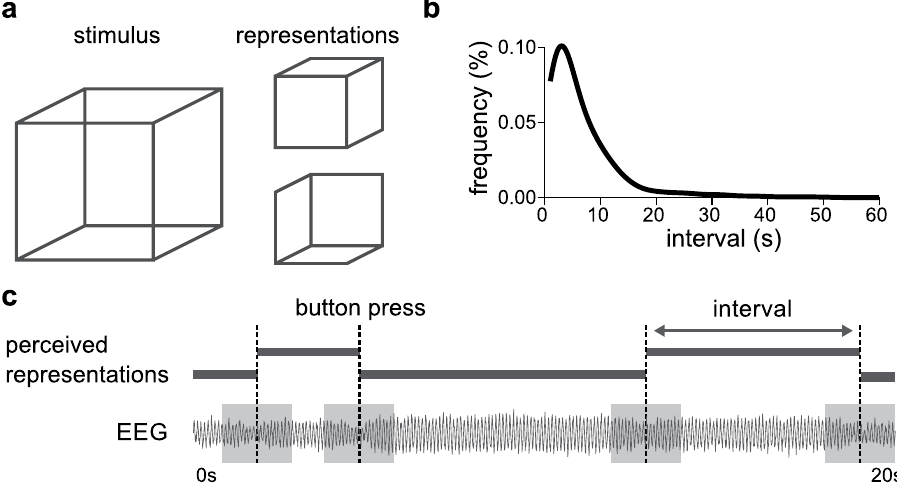
Figure 1. ( a ) The viewing of a Necker cube causes the perceptual system to alternate between two rivaling perceptual representations. The onset of each of the alternating percepts is reported by use of button presses. The perceptual duration of each individual percept is defined as the time interval between two button presses. ( b ) Probability distribution of perceptual durations of individual perceptual representations during Necker cube viewing after normal sleep. The distribution had a positive skew, with a mean value of 8.87 s and a median value of 5.94 s. ( c ) EEG data were recorded continuously while participants reported the perceived reversals of the representations of the ambiguous Necker cube by pressing a button. In the first analysis, alpha power was computed on whole perceptual durations, excluding the periods just preceding and following the button presses (gray areas). In a more finely grained second analysis, alpha power was calculated on a sliding window starting right after the emergence of a percept and evaluated on its predictive value for the perceptual duration of the present